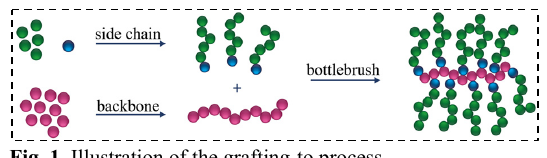
Fig. 1. Illustration of the grafting-to